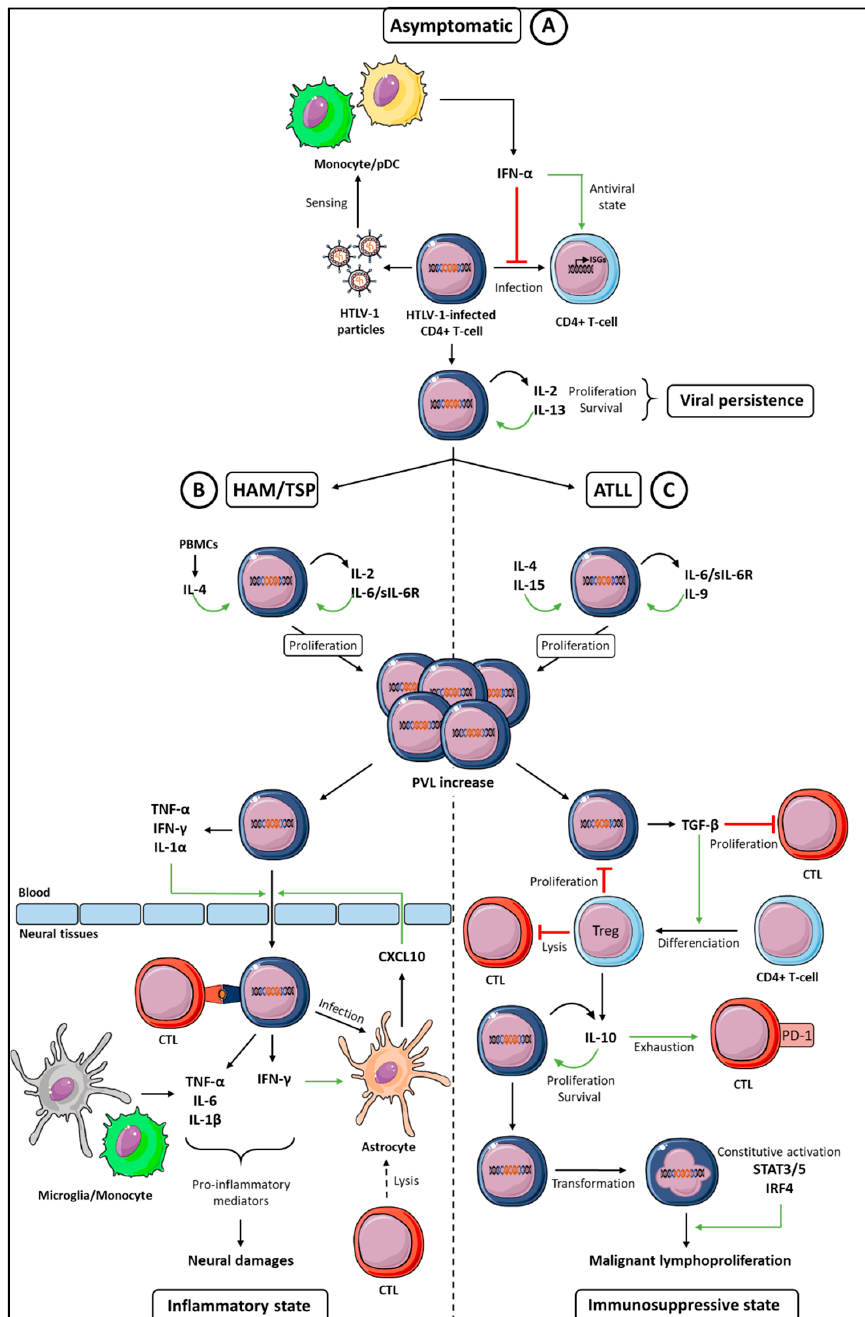
Figure 1. Global cytokine networks dysregulation during an HTLV-1 infection and HTLV-1-associated diseases. Three classes of cytokines can be involved in HTLV-1 persistence and diseases. ( A ) During the asymptomatic period that follows primo infection ( top ), IFN- α , IL-2, and IL-13 ensure, respectively, the antiviral control and proliferation of infected cells, both effects allowing viral persistence. ( B ) During the HAM/TSP disease ( left ), proinflammatory cytokines (IFN- γ , IL-1, TNF- α , and CXCL10) allow infiltration of the HTLV-1-infected T-cells in neural tissues that, in addition with IL-6, contribute to the chronic inflammatory state and neural damages. ( C ) During ATLL ( right ), immunosuppressive cytokines (TGF- β and IL-10) contribute to Cytotoxic T Lymphocytes (CTL) exhaustion, allowing an immunosuppressive state favorable to the malignant proliferation of HTLV-1-transformed cells. Green arrows indicate an increased function, red lines indicate a decreased function, and the curved arrow indicate autocrine proliferation. See text for details.